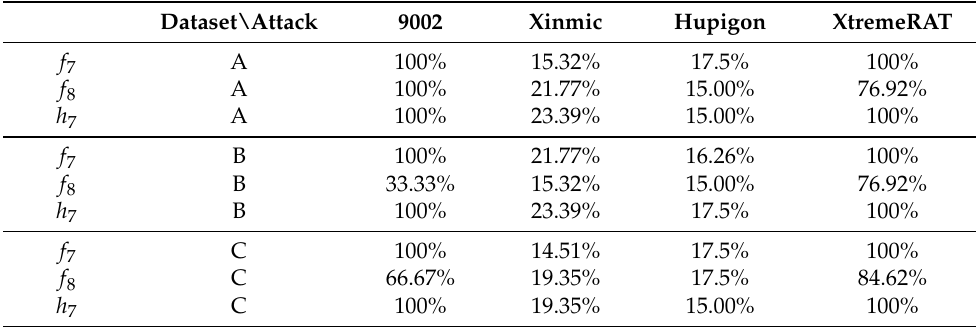
Table 10. Recall for feature sets f 7 , f 8 and h 7 on different datasets for selected